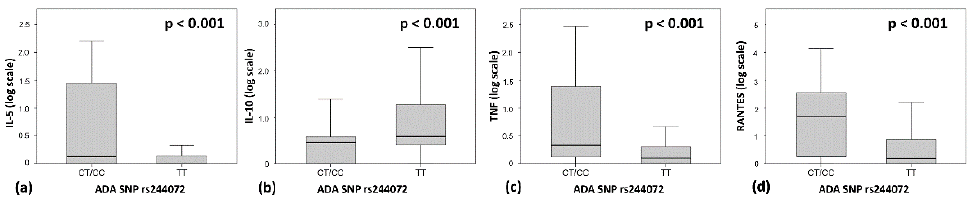
Figure 3. ADA SNP rs244072 and CSF inflammation. CSF concentrations of ( a ) RANTES, ( b ) TNF, ( c ) IL-5 and ( d ) IL-10 according to SNP rs244072 genotype (CT / CC vs. TT). To obtain a better graphical representation, CSF cytokines concentrations are shown in logarithmic scale. Mann–Whitney test p values after Benjamini–Hochberg correction are shown. Abbreviations: cerebrospinal fluid (CSF), tumor necrosis factor (TNF), interleukin (IL), single nucleotide polymorphism (SNP).